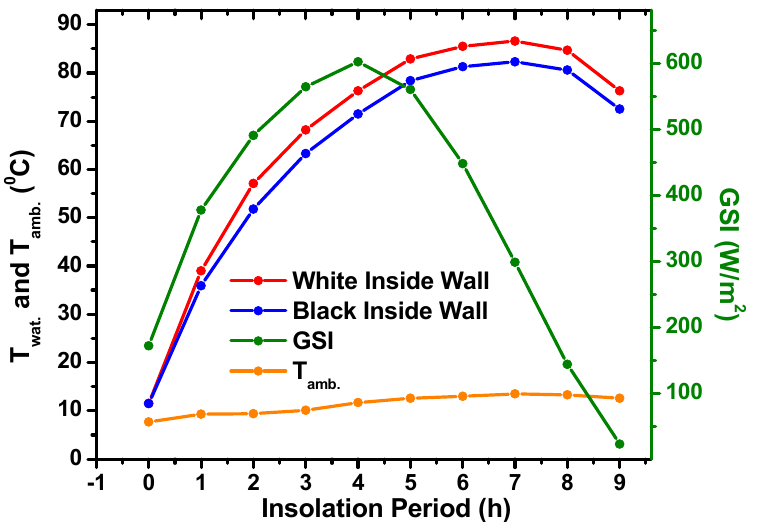
Figure 10. Water and ambient temperatures (T wat . and T amb .) and global solar intensity (GSI) vs. insolation period, white and black inside rooms; starting time: 8:00 a.m.; mostly sunny; date: 12/02/2022, Amman, Jordan.